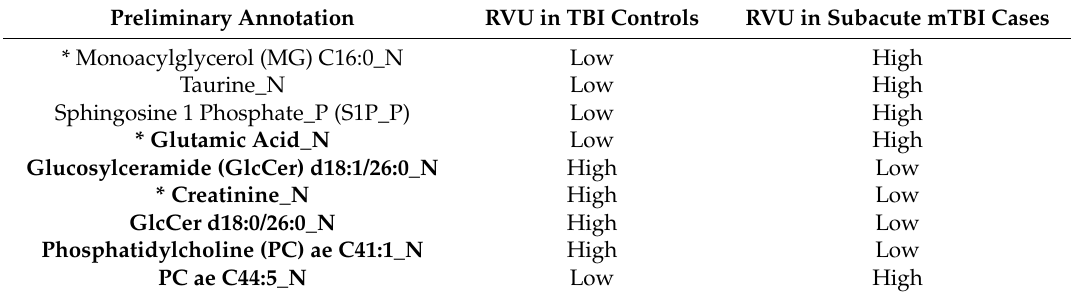
Table 2. Top 9 common metabolites derived using unbiased feature selection